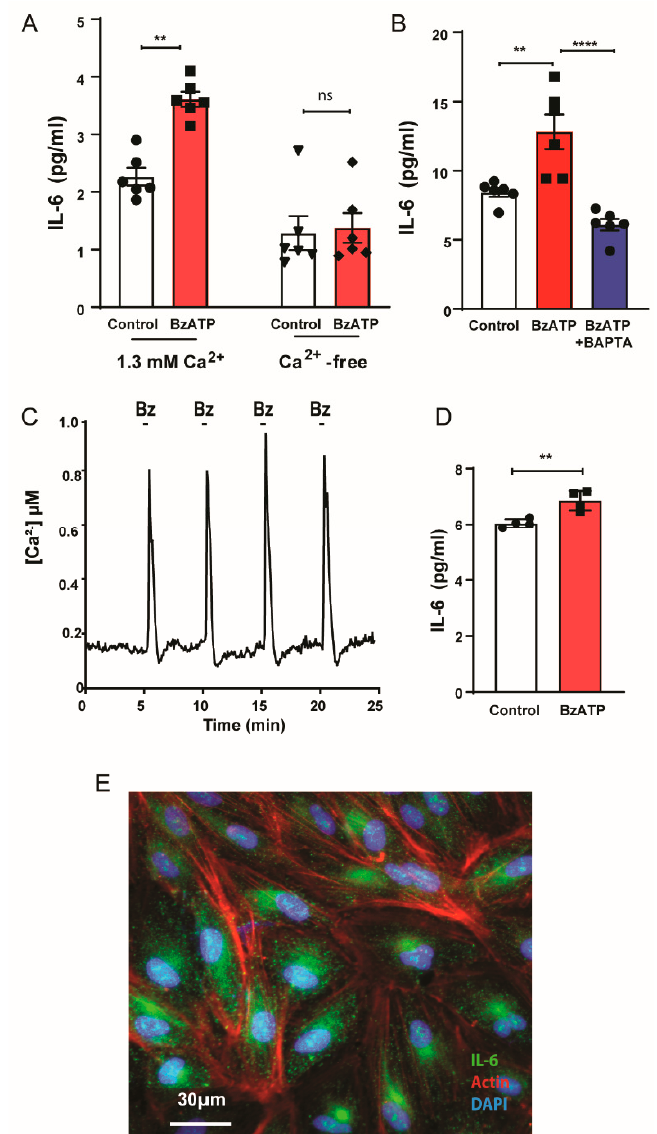
Figure 4. Calcium and IL-6 release from ARPE-19 cells. ( A ) The release of IL-6 triggered by